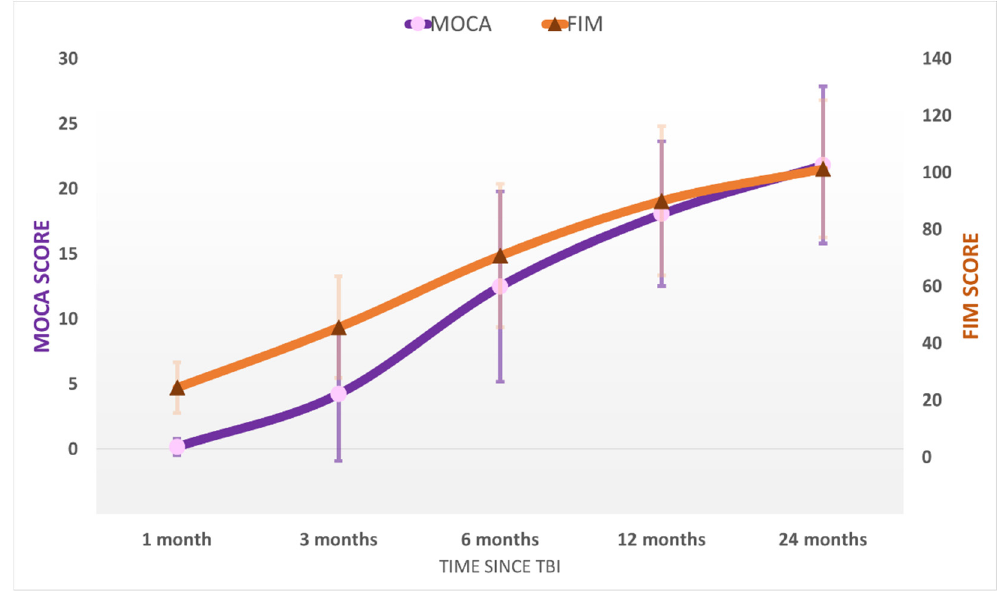
Figure 3. The average MOCA and FIM scores in the study population at the five evaluations after the TBI. Error bars represent the standard deviation.